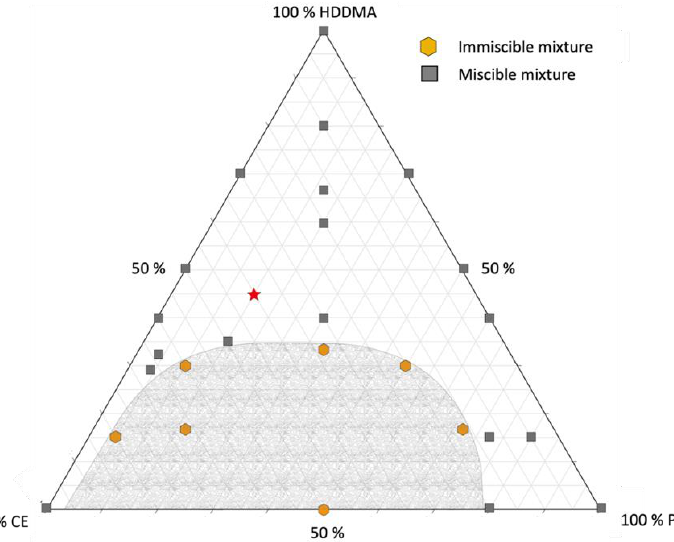
Figure 2. Ternary phase diagram of CE/PBUDA/HDDMA in a liquid state at 25 ◦ C. The shaded region indicates immiscibility, and the star represents the experimental composition selected for further analysis in this study. Table 3. Composition of the reference formulation and the formulations modified with various concentrations of PBGMA, and their associated viscosities measured at 25 ◦ C.